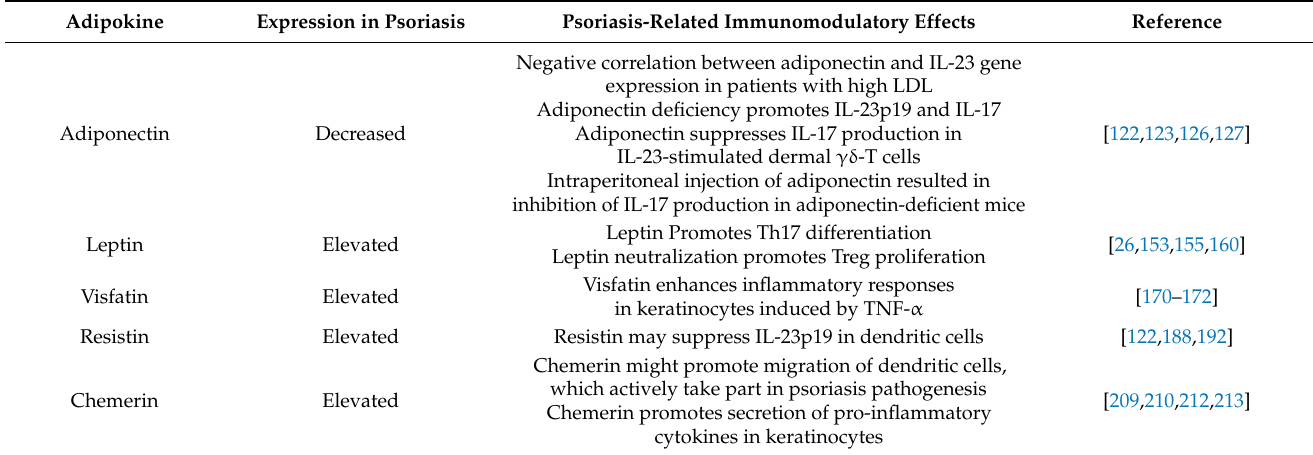
Table 1. Summary of selected adipokines and mechanisms related to the pathogenesis of